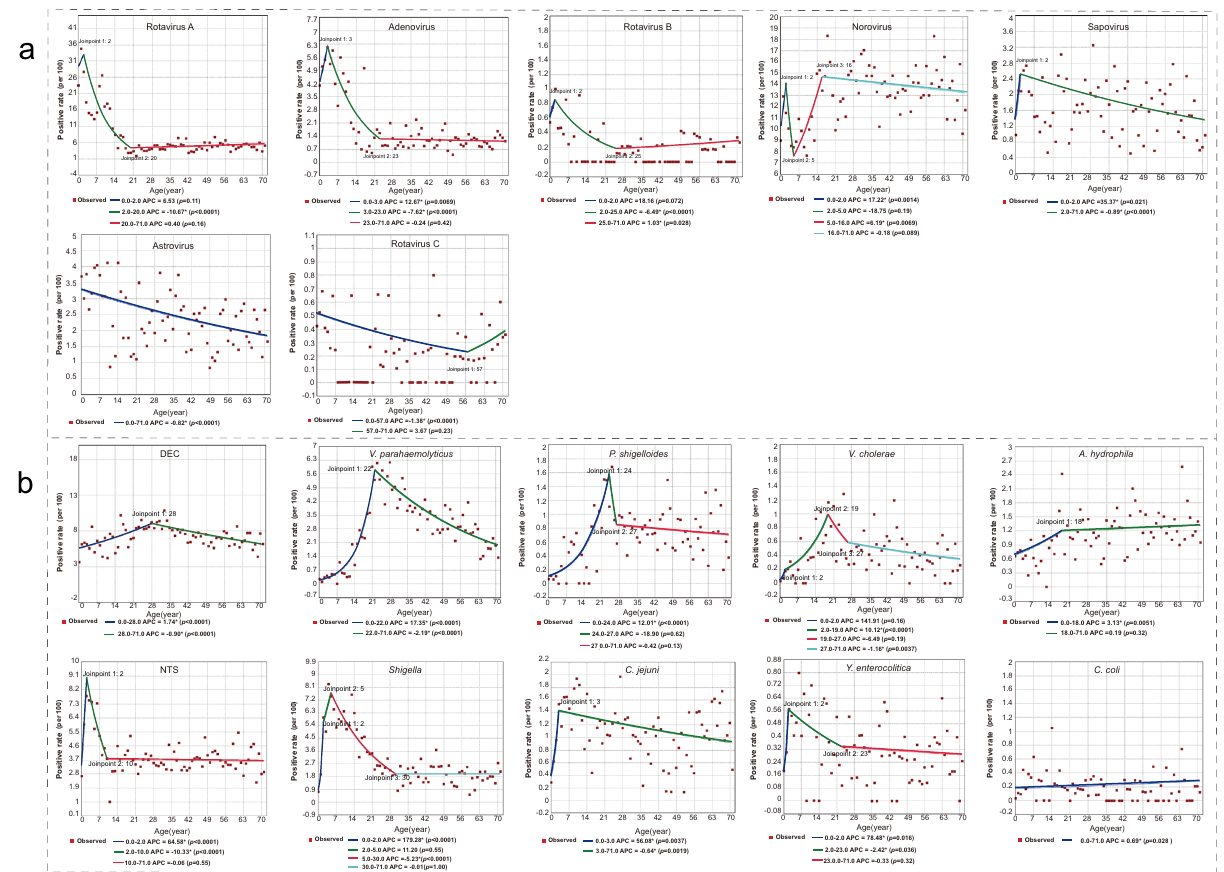
Fig. 4 The joinpoint regression of the positive rates of each enteropathogen by age of the patient. a Viral pathogens. b Bacterial pathogens. A red point indicates the positive rate of patients in terms of age and the colored curves indicate fi tted patterns by the red points. Legends give the annual percentage change (APC) value of each fi tted curve for each enteropathogen. *Indicates that the APC is signi fi cantly different from zero at p < 0.05. A normal ( Z ) distribution was used to assess the signi fi cance of the APC. All statistical tests were two-sided and p < 0.05 was statistically signi fi cant. DEC diarrheagenic Escherichia coli ; NTS nontyphoidal Salmonella . Source data are provided as a Source Data fi